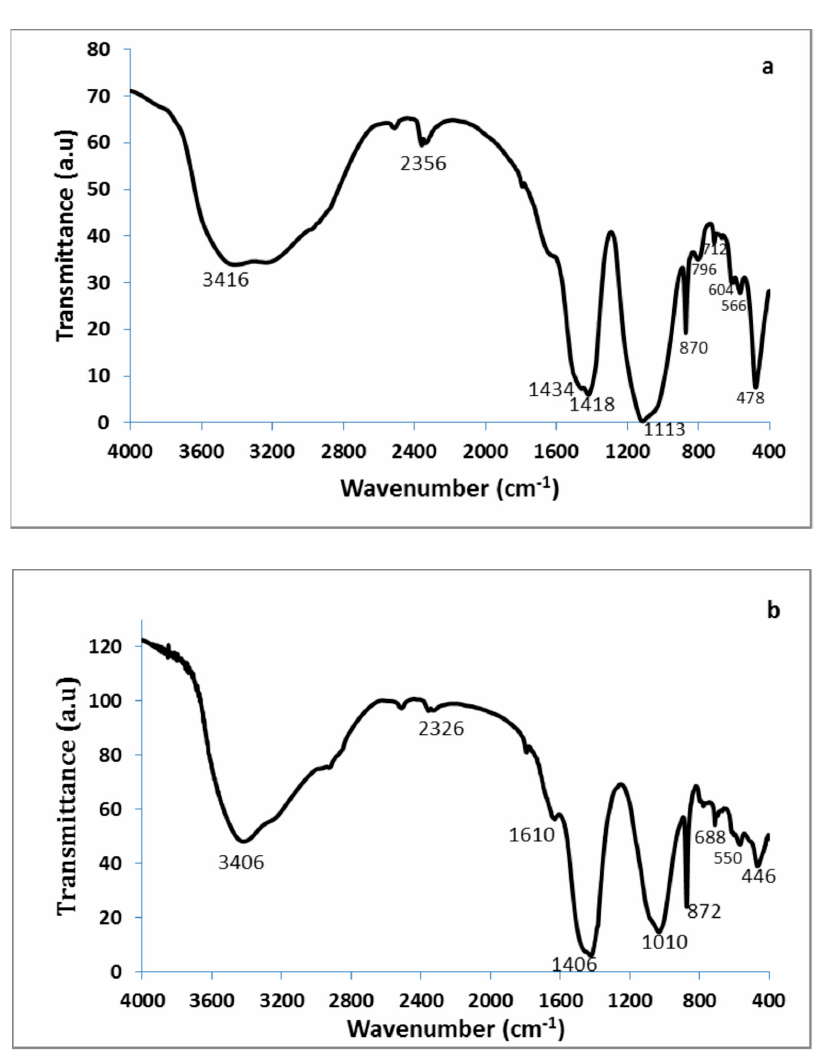
Figure 4. FTIR spectra of OK / MSW ash stabilized with ( a ) silica fume (SIF) and ( b ) meat and bone meal biochar (MBM b ).